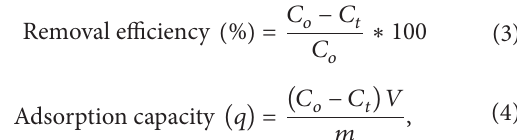
Concentration of p-xylene ( mg / L